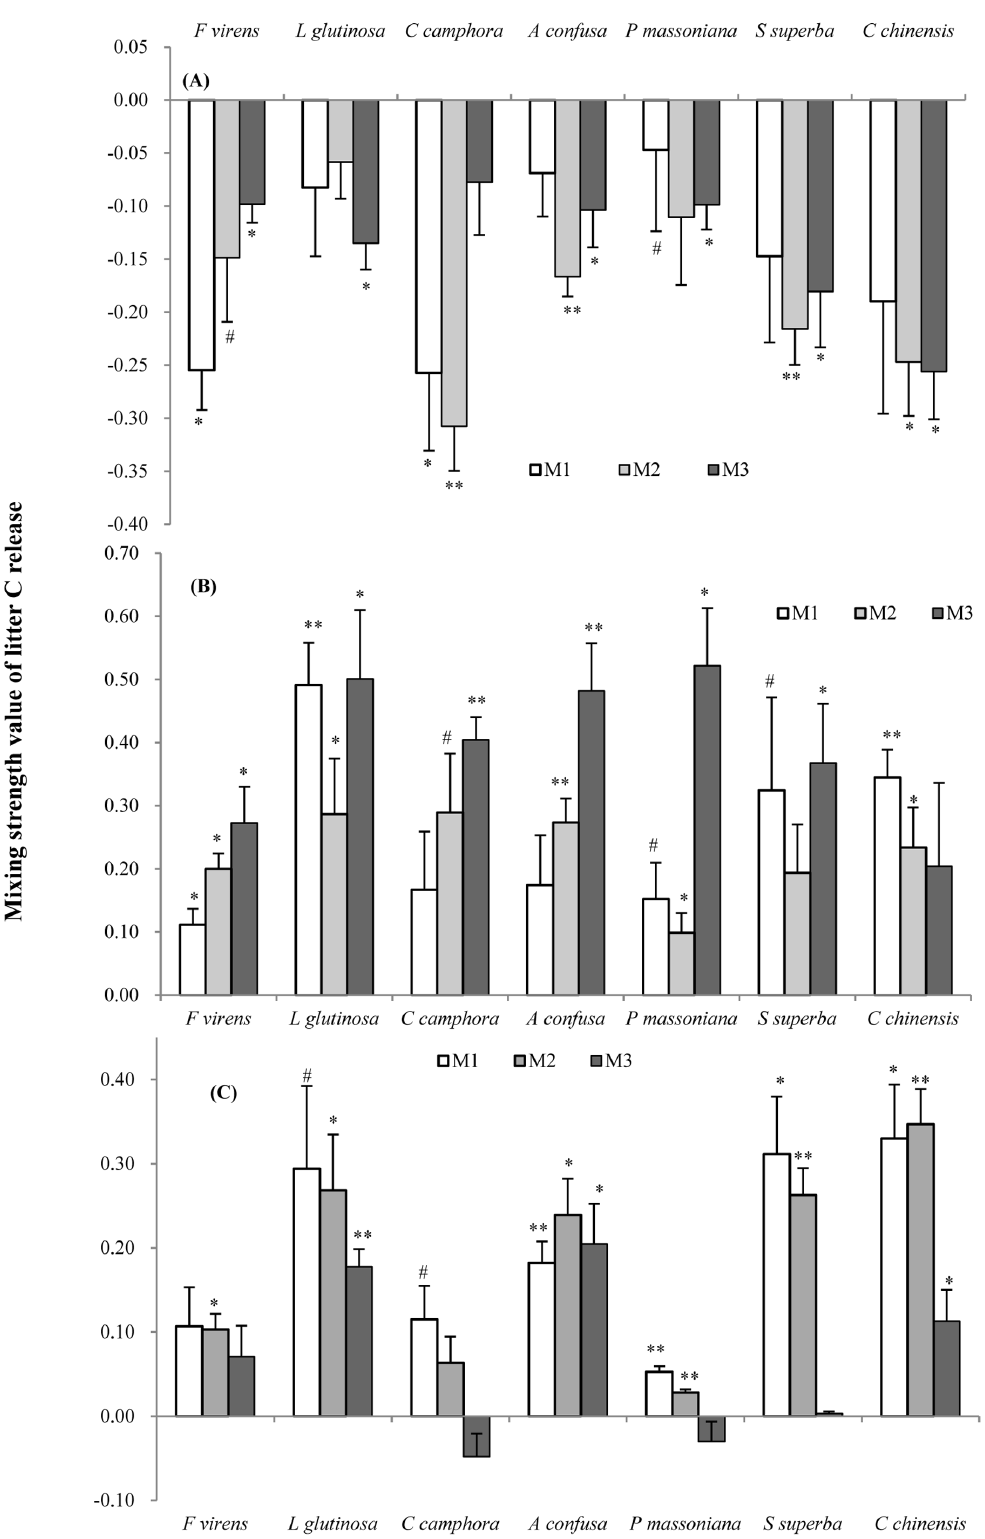
Figure 4. Mean mixing interaction strength values ( + SE, n=4) of litter C releases after 60 (A), 128 (B) and 180 (C) days decay. M 1 (1:4, mixture with 20% exotic litter), M 2 (1:1) and M 3 (4:1, mixture with 80% exotic litter) represent 3 different litter mixing ratio of M. micrantha to native species. Non-additive interactions are significantly different from zero with (**) at P , 0.01, (*) at P , 0.05, and with ( # ) at P , 0.10 tested separately with one sample t test. See Table S6 for observed C release.